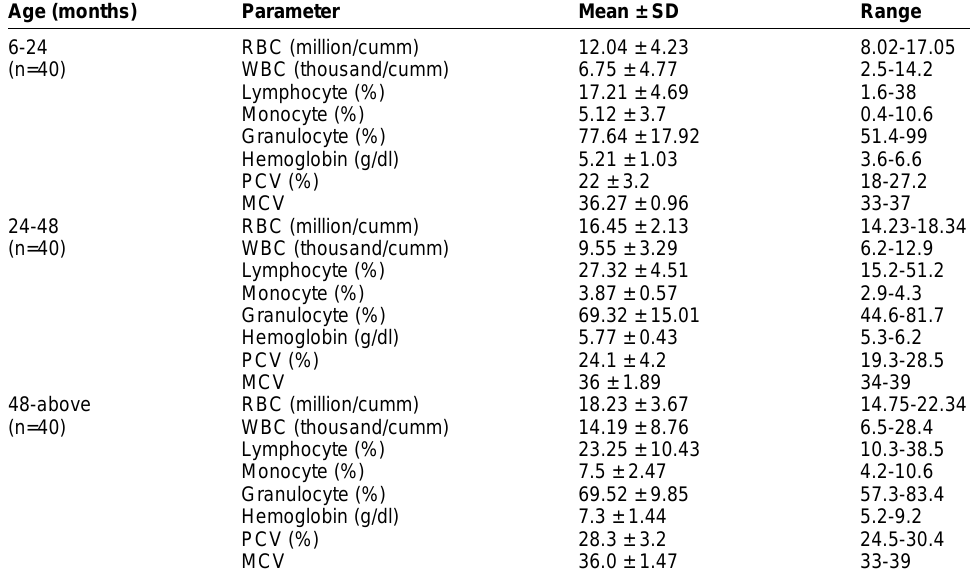
Table-1. Hematological status of Black Bengal and Jamnapari goats Age